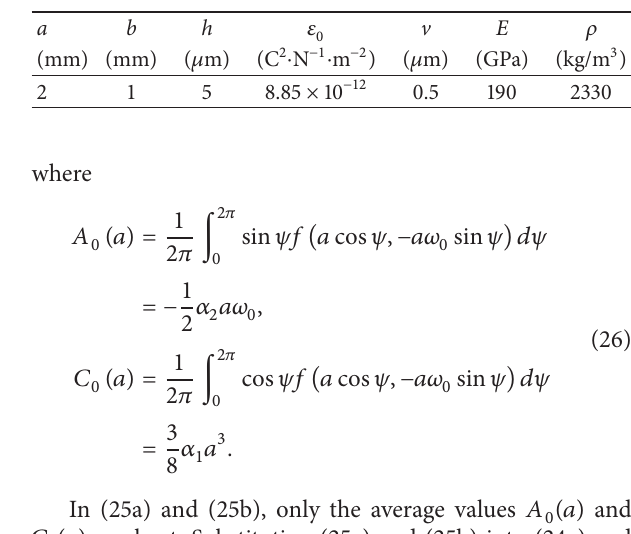
Table 1: Parameters of the micro